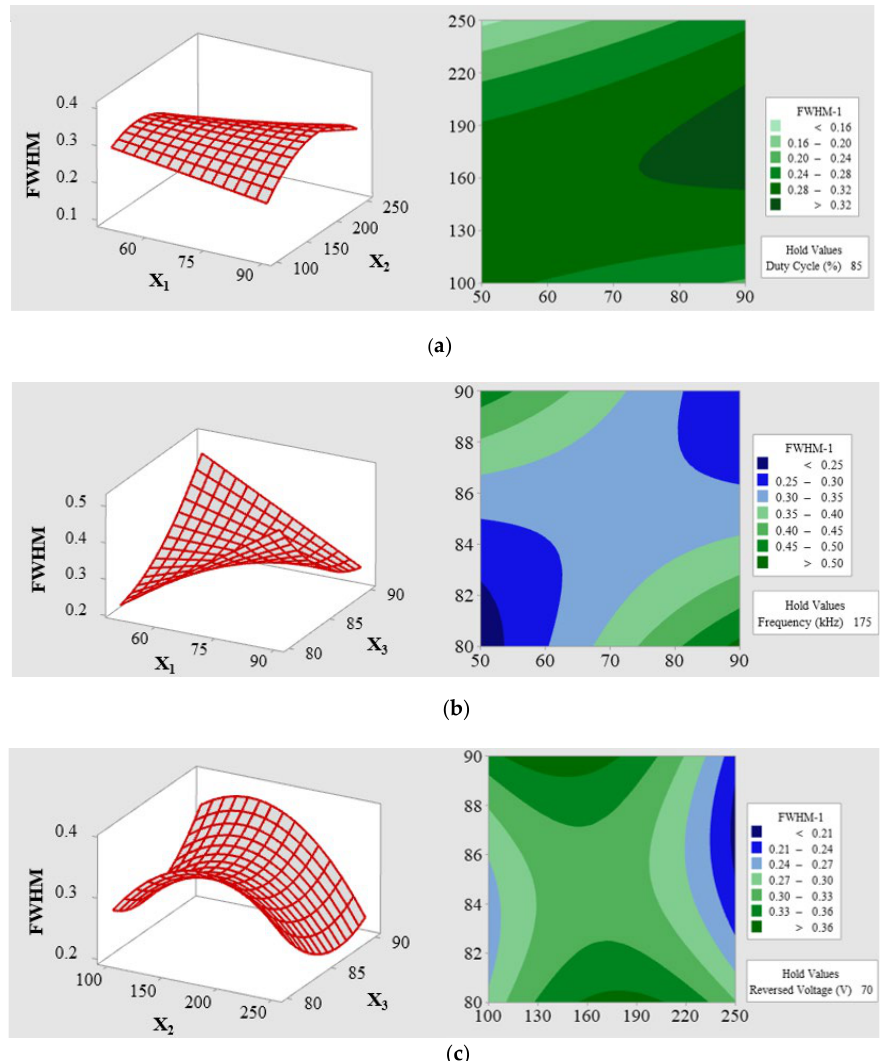
Figure 10. 2D views (factor vs. level) and 3D views. ( a ) 3D in X 1 *X 2 : frequency interacting with re- verse voltage, X 3 remains a constant; ( b ) 3D in X 1 *X 3 : duty cycle interacting with reverse voltage, X 2